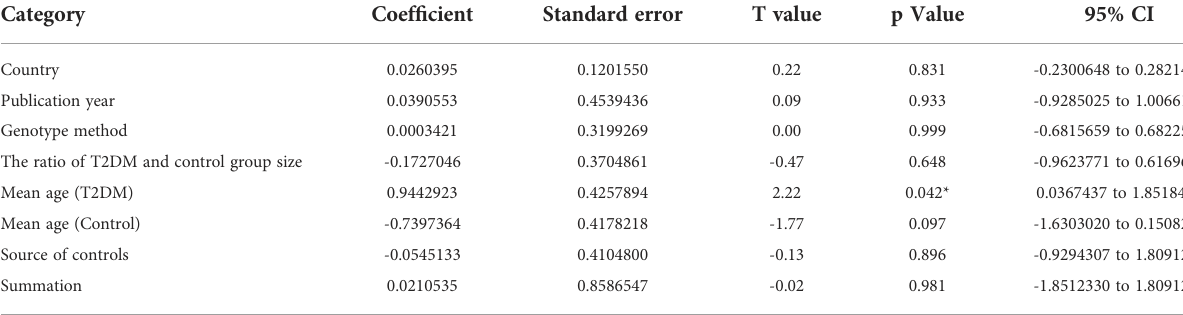
TABLE 2 The meta-regression results based on the dominant model involving 23